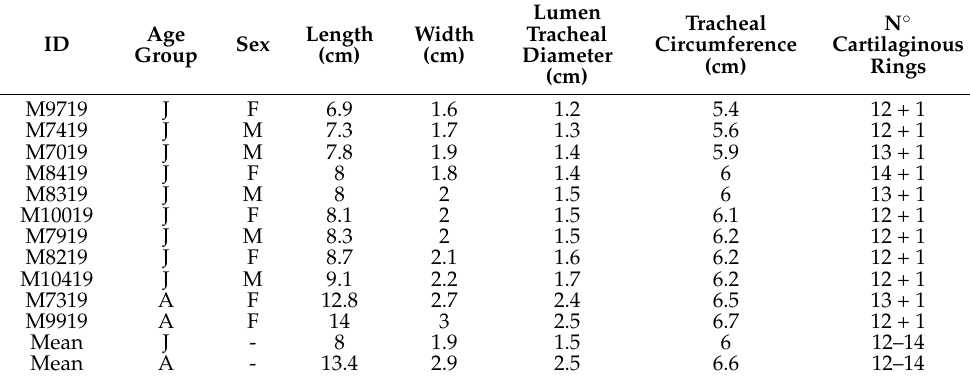
Table 1. Morphometric data of the trachea from the 11 individuals of Arctocephalus australis investi- gated in the present study. A: adult; J: juvenile.